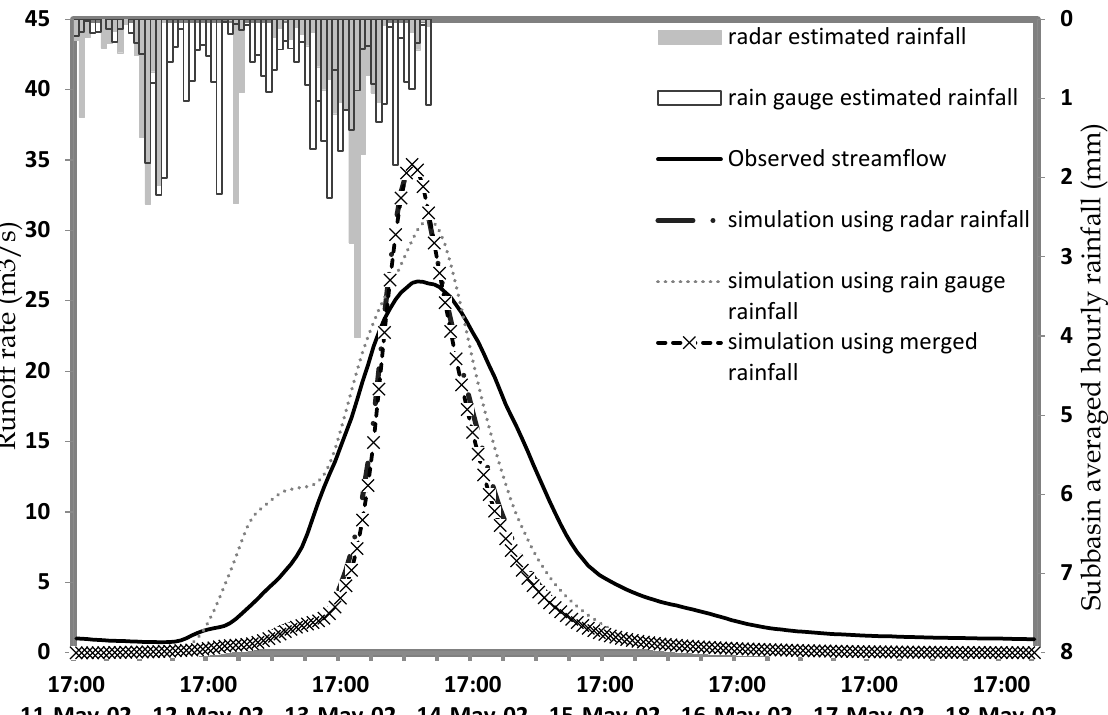
Figure 22. Comparison of estimated and observed hydrographs using different rainfall estimates for the 21 May 2001 event with Green and Ampt modeling option.